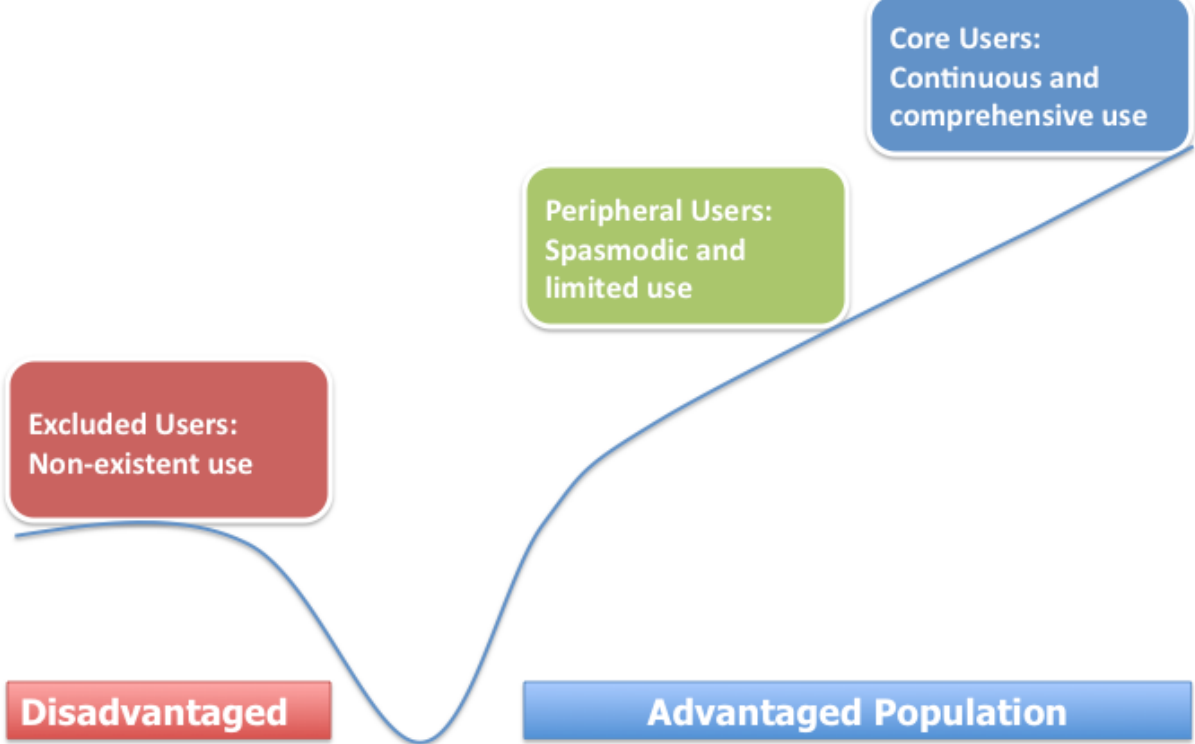
Figure 1. Digital divide (model adopted from Murdock [22]: three groups of ICT users were described in terms of levels of access and use; blue line represents the conceptual valley and barriers of the digital